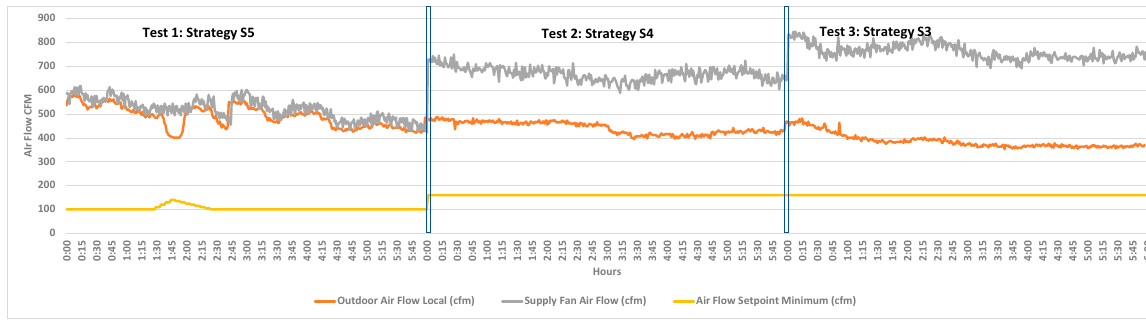
Figure 13. OA and supply airflow rates when various strategies were applied.